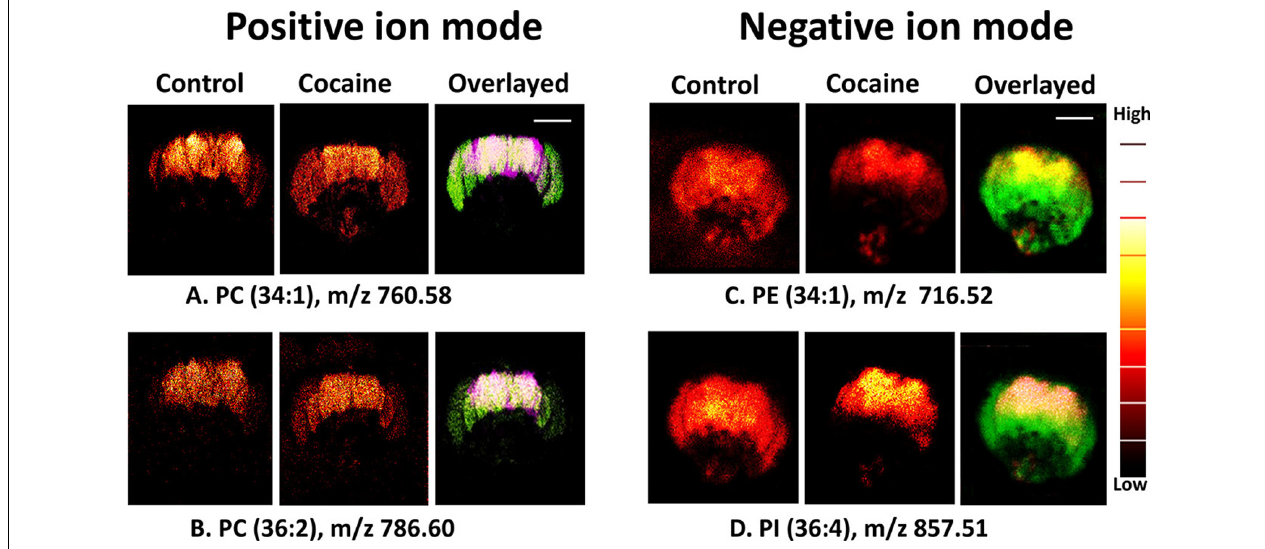
FIGURE 2 | Distribution of biomolecules in the Drosophila brain before and after cocaine treatment by ToF-SIMS in positive and negative ion modes. Image area: 800 × 800 µ m 2 and 256 × 256 pixels; pixel size, ∼ 3 µ m. Overlaid images: (A,B) purple, control brain; green, cocaine-treated brain (positive ion mode); (C,D) green, control; red, treated brain (negative ion mode). Scale bar: 200 µ m. A color “thermal” scale is shown. This shows marked differences in the distribution of lipids after the introduction of cocaine, particularly in the negative ion mode. This may indicate that behavioral changes induced by cocaine can be related to changes in lipid distribution, and can be observed through SIMS. Reprinted with permission from Philipsen et al. (2018).